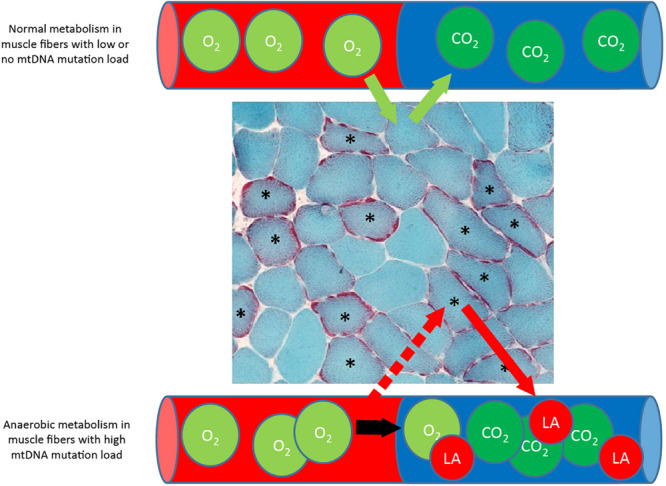
Metabolism in muscle fibers with low and high mtDNA mutation load. Muscle section from patients with mtDNA mutation, stained with Gomori Trichrome staining showing multiple ragged red (∗) muscle fibers that indicate accumulation of dysfunctional mitochondria due to high mtDNA mutation load. During exercise, fibers with a high mtDNA mutation load is dependent on anaerobic metabolism alone due to mitochondrial dysfunction, while adjacent muscle fibers with low or no mtDNA mutation load will be able to oxidize fat and glucose and take up lactate (La) for oxidation.